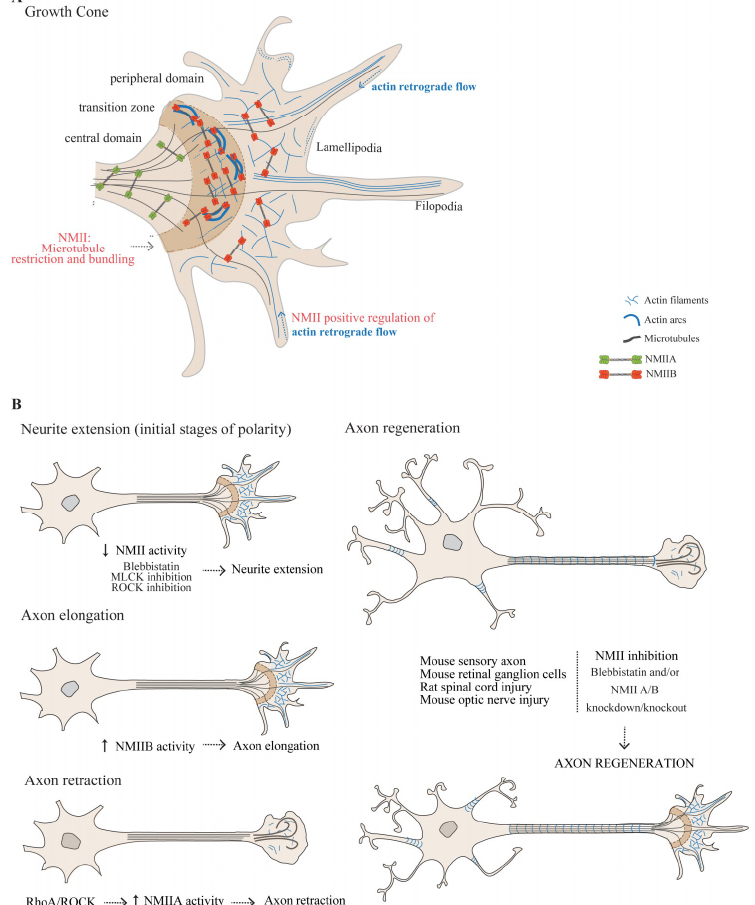
Figure 2. NMII in axon elongation, retraction and regeneration. ( A ) Schematic representation of the growth cone. The growth cone includes a central domain, mainly consisting of bundled microtubules (grey lines), a transition zone, enriched in actin arcs (blue hemicircular lines) and a peripheral domain, enriched in actin (blue lines) in the form of lamellipodia and filopodia. Actin bundles assemble near the growth cone leading edge, translocate rearward by retrograde flow towards the transition zone (blue dashed arrows in the peripheral domain) and recycle through bundle severing. NMIIA (green) is mainly located within the central domain and NMIIB (red) in the transition zone and peripheral domain. ( B ) General effect of NMII in neurite extension, axon elongation, retraction and regeneration. During early neurite extension pharmacological inhibition of NMII either directly using blebbistatin, or indirectly through the inhibition of the upstream regulators MLCK or ROCK, promotes axon elongation (upper left panel). When analyzing the effect of different NMII isoforms in axon elongation, in general terms, NMIIB is required for axon elongation (middle left panel) while NMIIA participates in neurite retraction (bottom left panel). In the course of axon regeneration (right panel) NMII inactivation through blebbistatin and / or NMIIA / B downregulation / knockdown, enhances axon